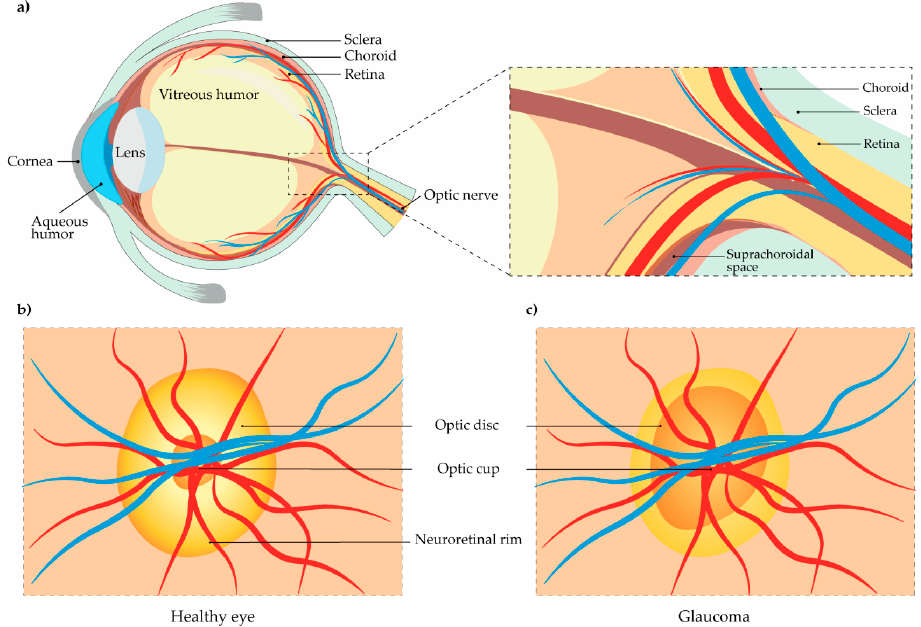
Figure 1. ( a ) Morphology of the eye; ( b ) Optical nerve head in a healthy eye; ( c ) The optical nerve head in glaucoma is characterized by vertical elongation of the cup and loss of the neuroretinal rim.